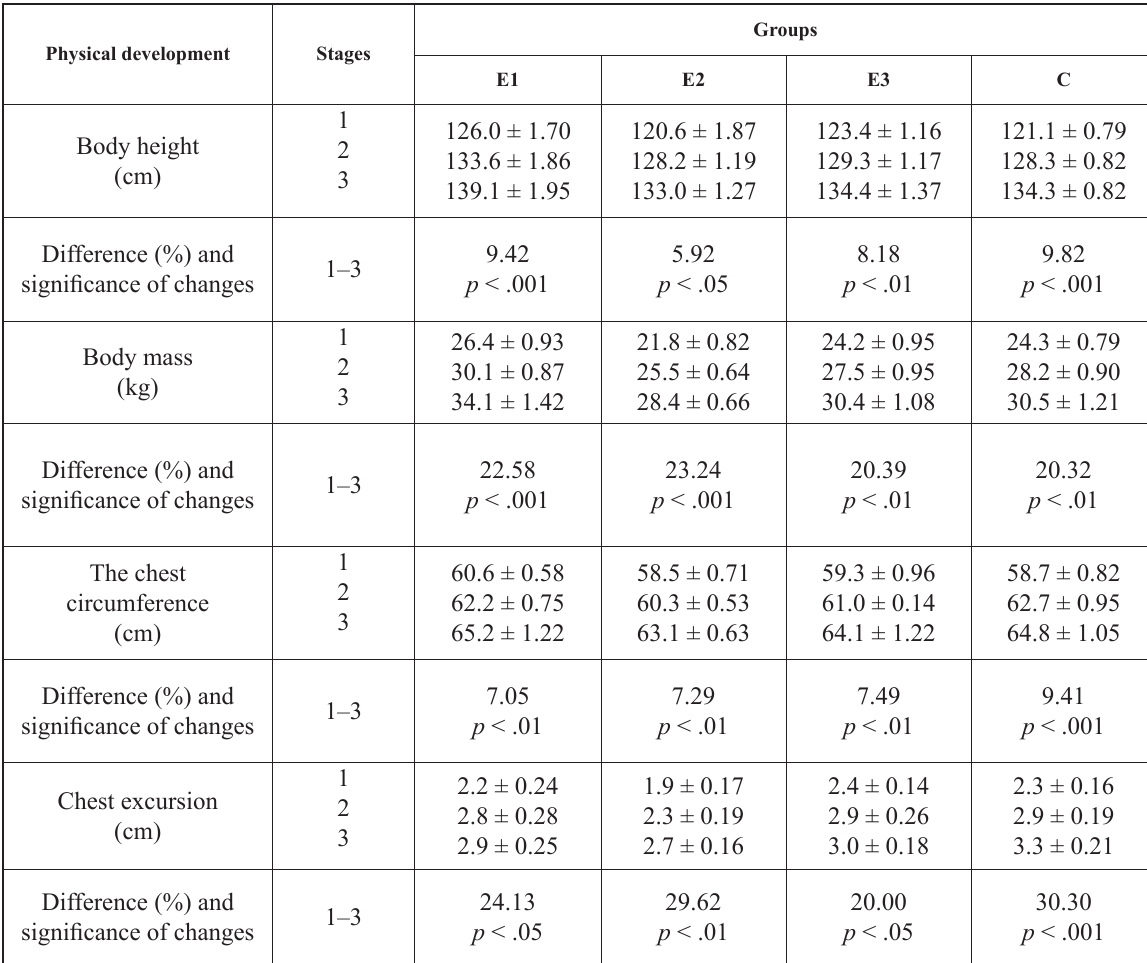
Table 1. Results of changes in the physical development of girls, students of the second and the third grades ( X ± Sx )